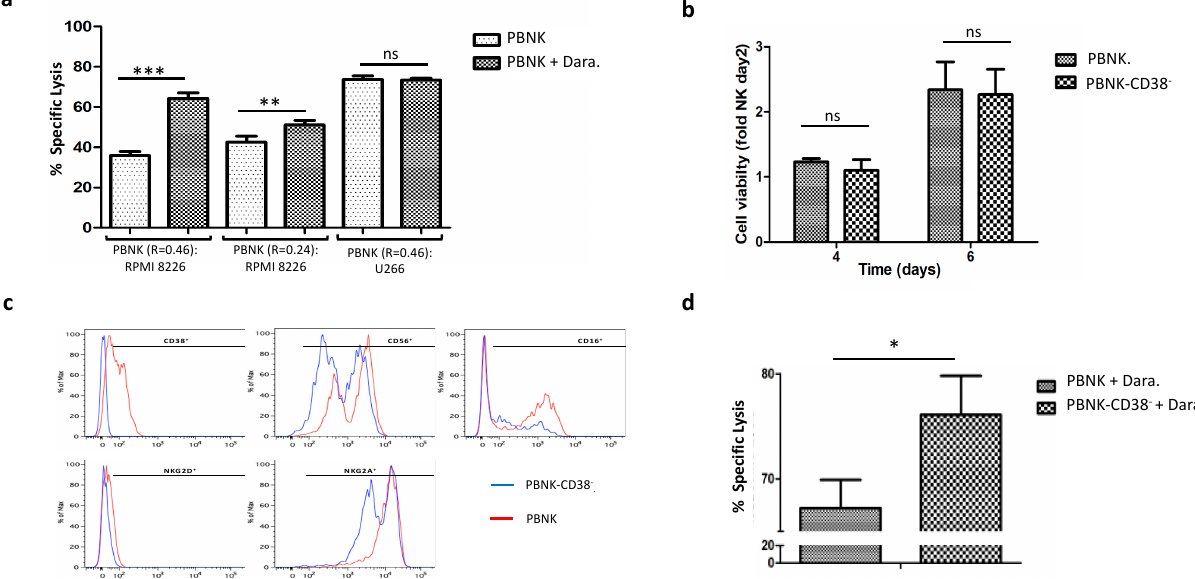
Figure 4. Selection and pretreatment of expanded PBNK cells with Daratumumab to increase synergy in combinatorial therapy with mAbs. ( a ) Graph with the specific lysis results in a combinatorial therapy with PBNK cells (R = 0.46 and R = 0.24) and Daratumumab against MM cell lines RPMI 8226 and U266. Measured using the bioluminescence imaging assay at a 1:1 effector-to-target ratio for 24 h. ( b ) Summary graph with the viability over time of PBNK cells after treatment with Daratumumab (PBNK-CD38 − ) for 48 h, compared to the untreated population. ( c ) FACS phenotypic analysis comparing the PBNK cells treated and not treated with Daratumumab for 48 h. ( d ) Graph with the cytotoxicity of pretreated PBNK-CD38 − cells and original population with heterogeneous expression of CD38 against RPMI 8226 with Daratumumab. Combinatorial cytotoxicity was measured using the bioluminescence imaging assay at 1:1 effector-to-target ratio for 24 h. Data in ( b ) are means ± SEM of three expanded PBNK cell donors. Data in ( a , d ) are presented as means ± SD of each expanded PBNK cells in three technical replicates. *, p < 0.05, **, p < 0.01, ***, p < 0.001, based on Student’s t